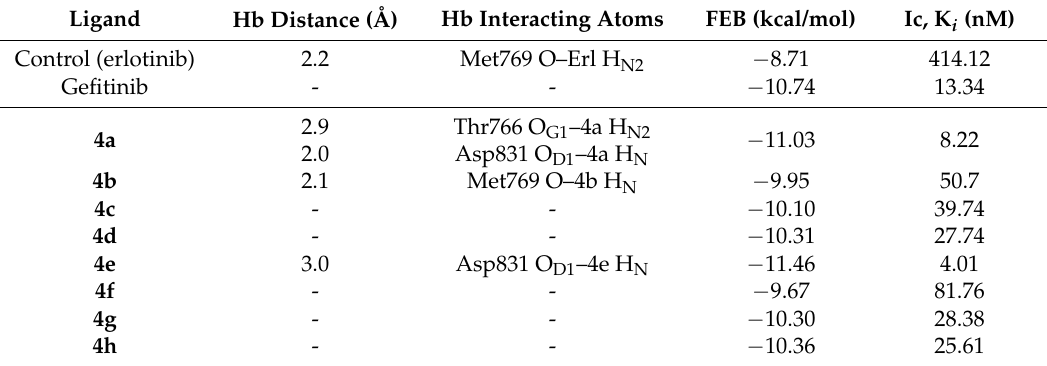
Table 3. Calculated binding free energy and estimated inhibition constant (K i ) of erlotinib (as control), gefitinib and quinazoline-indole hybrids 4a – h with epidermal growth factor receptor (EGFR) kinase domain.